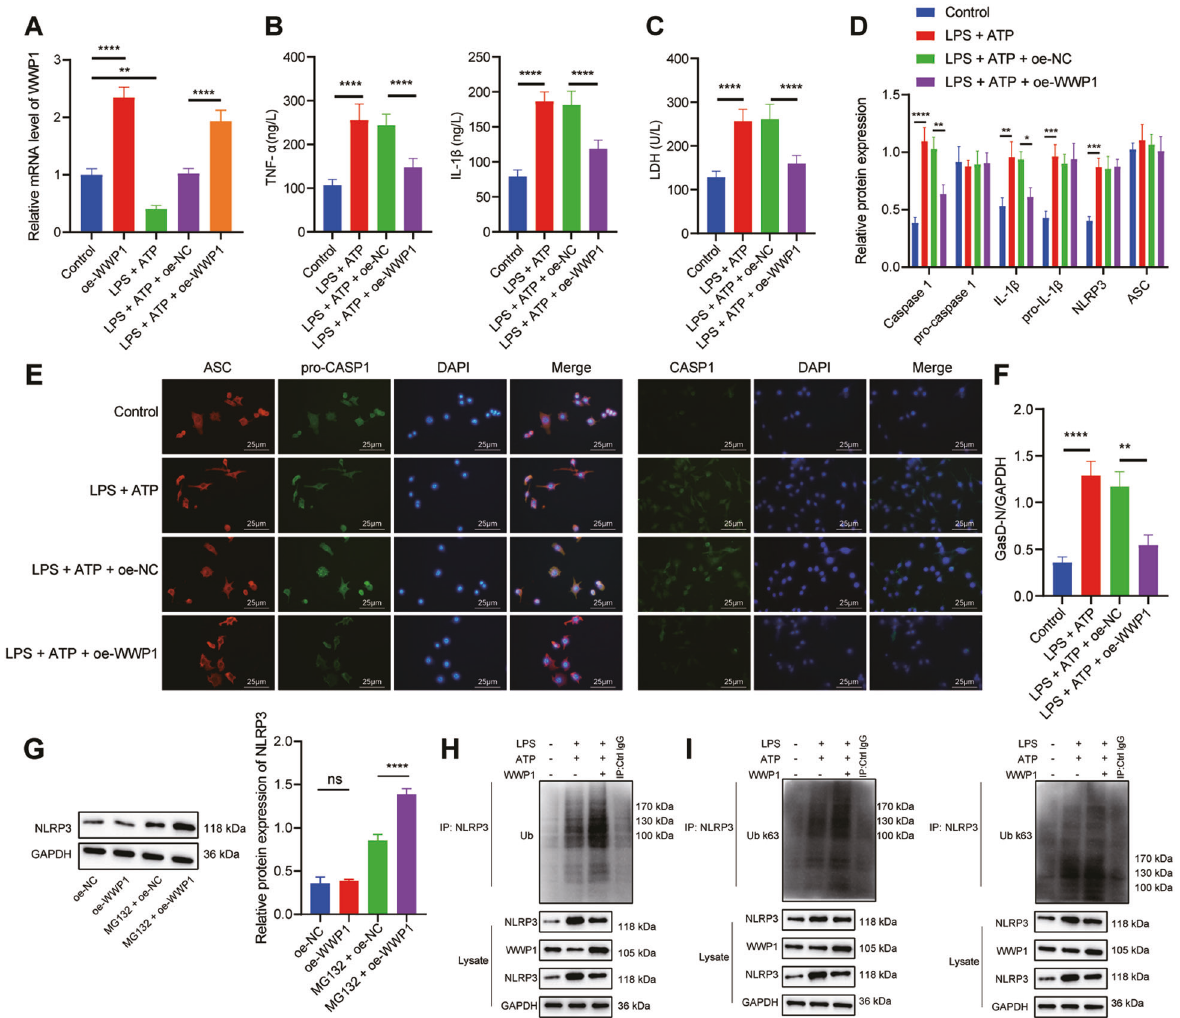
Fig. 2 Overexpression of WWP1 promotes NLRP3 ubiquitination to inactivate NLRP3 in fl ammasomes and caspase-1-mediated cleavage of GSDMD. A The expression of WWP1 detected by RT-qPCR. B The expression of TNF- α and IL-1 β detected by ELISA. C LDH level in cells with different treatment. D The activation of NLRP3 in fl ammasomes detected by Western blot assay. E The co-localization of ASC with pro-caspase- 1 and caspase-1, respectively in macrophages detected by immuno fl uorescence. F Protein levels of GasD-N and GasD-FL detected by Western blot assay. G The protein expression of NLRP3 in oe-WWP1-treated cells in response to MG132 treatment. H The ubiquitination of NLRP3 detected by Co-IP (WWP1: 105 kDa; NLRP3: 118 kDa). I K63 ubiquitination and K48 ubiquitination of NLRP3 detected by Co-IP (WWP1: 105 kDa; NLRP3: 118 kDa). * p < 0.05; ** p < 0.01; *** p < 0.001; **** p < 0.0001. ‘ ns ’ indicates no signi fi cant difference. Cell experiments were repeated three